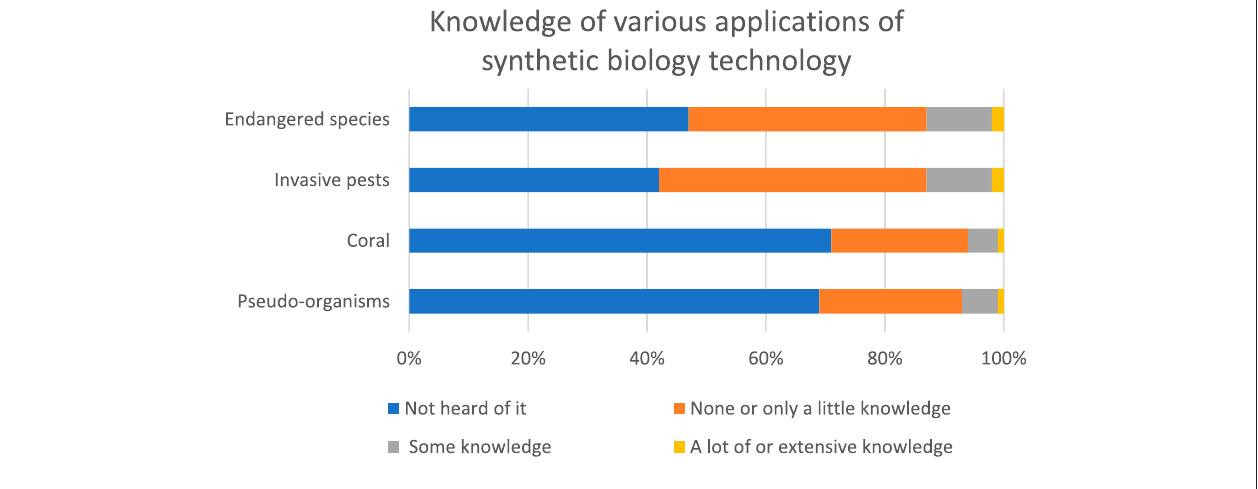
FIGURE 2 | Knowledge of various applications of synthetic biology